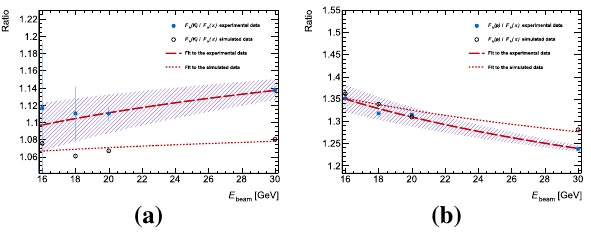
Fig. 23 a F h ( K )/ F h (π) as a function of E beam obtained using exper- imental (blue circles) and simulated data (black empty circles). b F h ( p )/ F h (π) as a function of E beam obtained using experimental (blue circles), and simulated data (black empty circles). In the case of exper- imental results uncertainties include statistical and systematic effects combined in quadrature, but for simulated results only the statistical uncertainties are shown. The dashed (dotted) red curves are fits of the functional forms (23) and (24) to the experimental (simulated) data points. In case of experimental determinations the dashed blue hashed bands were obtained by using the correlated systematic uncertainties